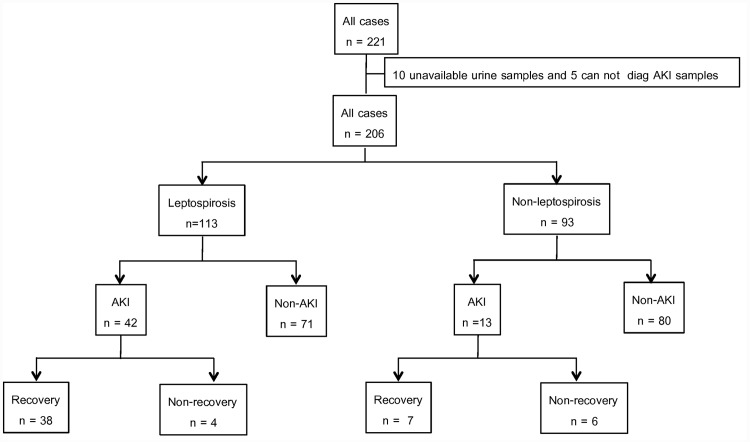
Subject disposition for the lepto Thai study cohort.